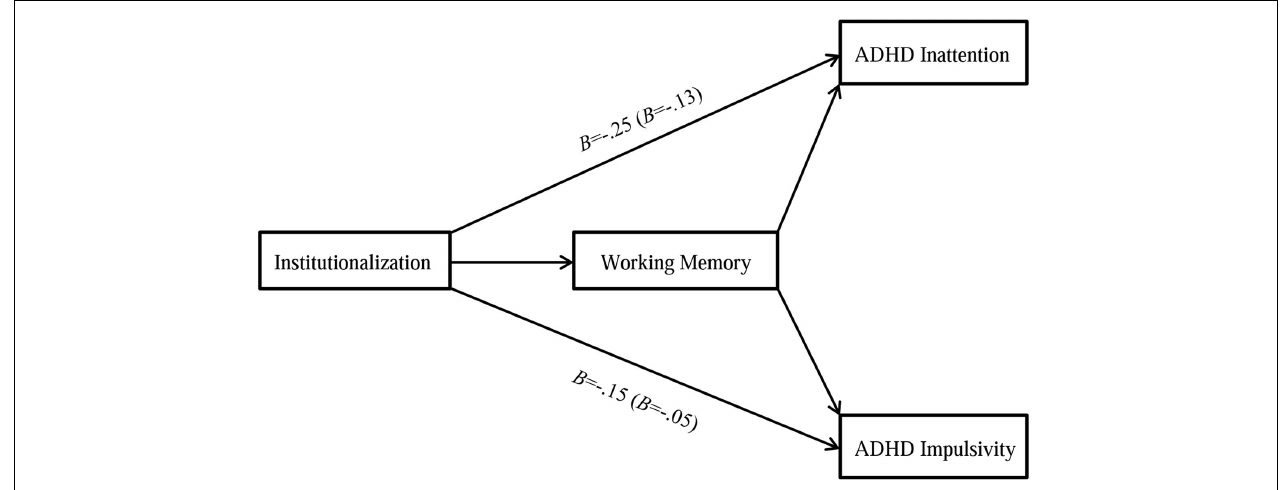
FIGURE 1 | Full mediation models linking exposure to institutionalization to inattention and impulsivity through working